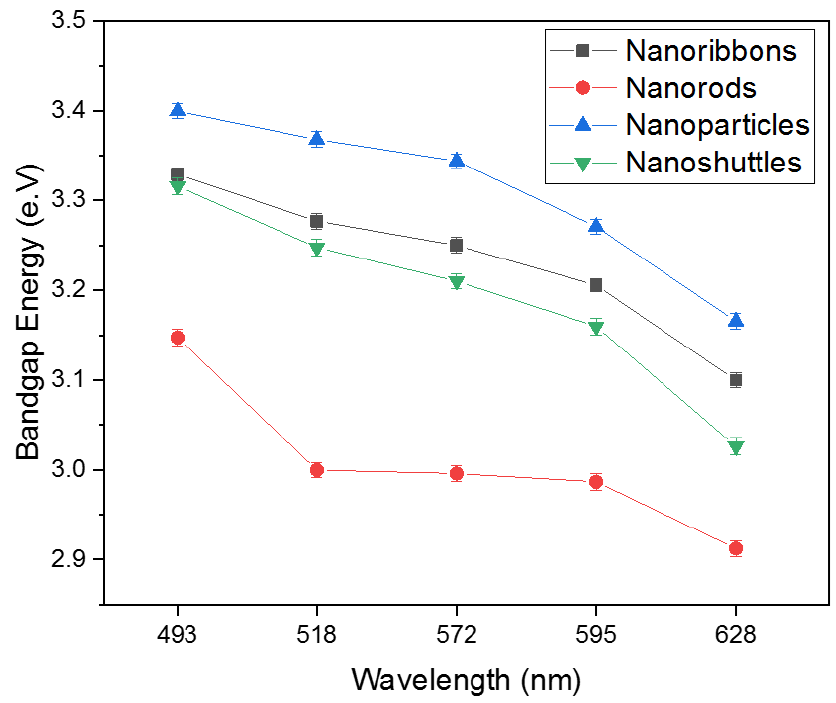
Figure 2. Variation of bandgap energy with different wavelengths.